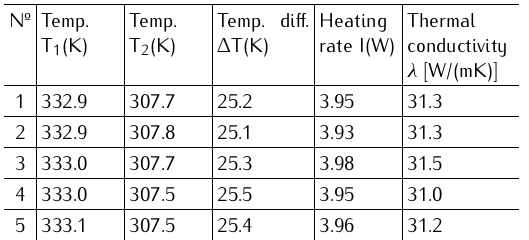
Table 3. Thermal conductivities of TMA bodies vacuum-sintered at 1773 K.